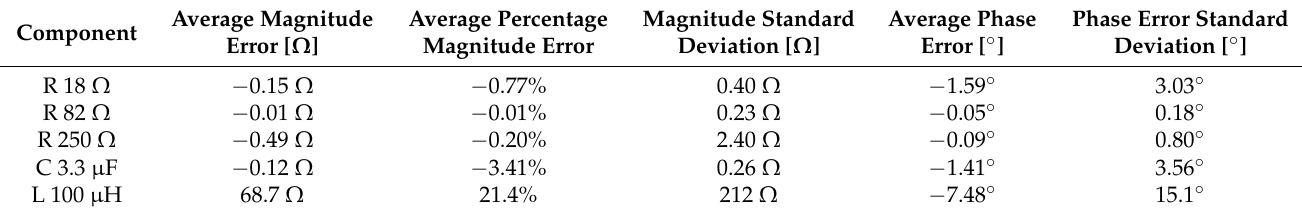
Table 2. Average magnitude and phase errors from the measure of discrete RLC components.